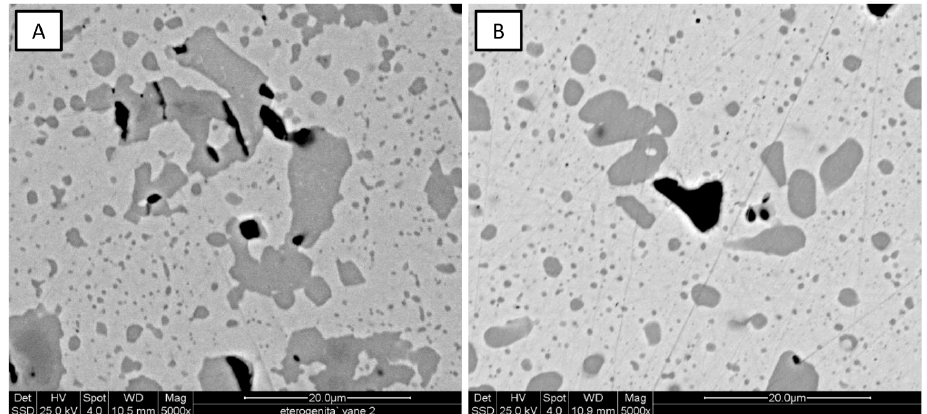
Figure 3. SEM micrographs of ( A ) X105 and ( B ) X105 ‐ C samples.